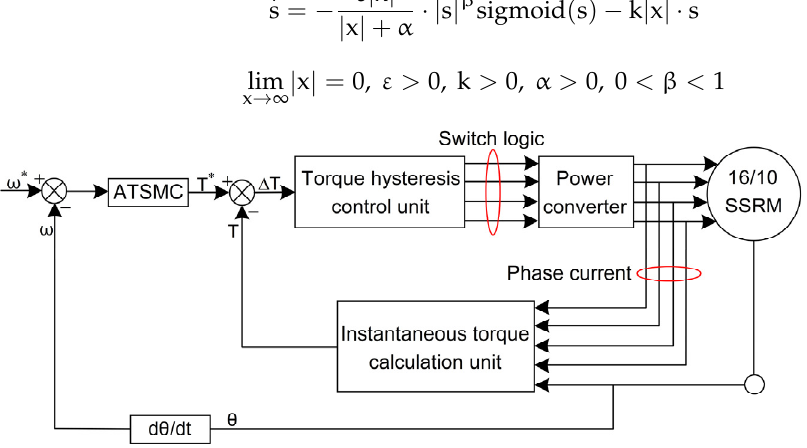
Figure 13. Control block diagram of the improved DITC system based on ATSMC that is used in 16/10 SSRM.